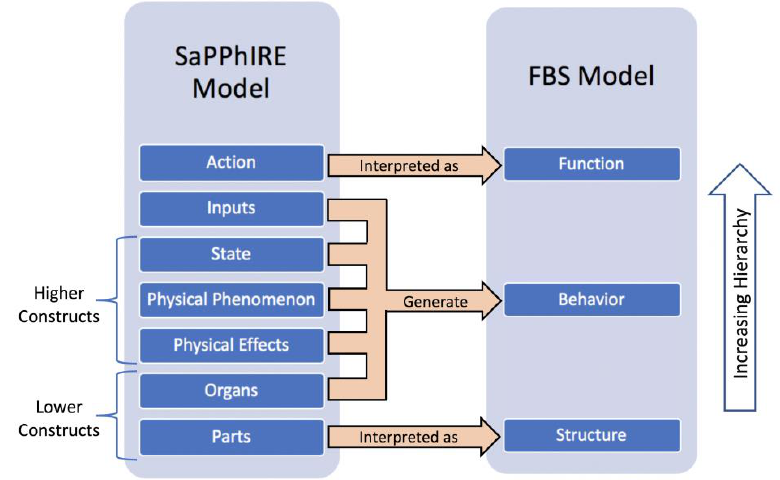
Figure 2. Mapping of SAPPhIRE model to FBS model, adapted from Sarkar and Chakrabarti [25].